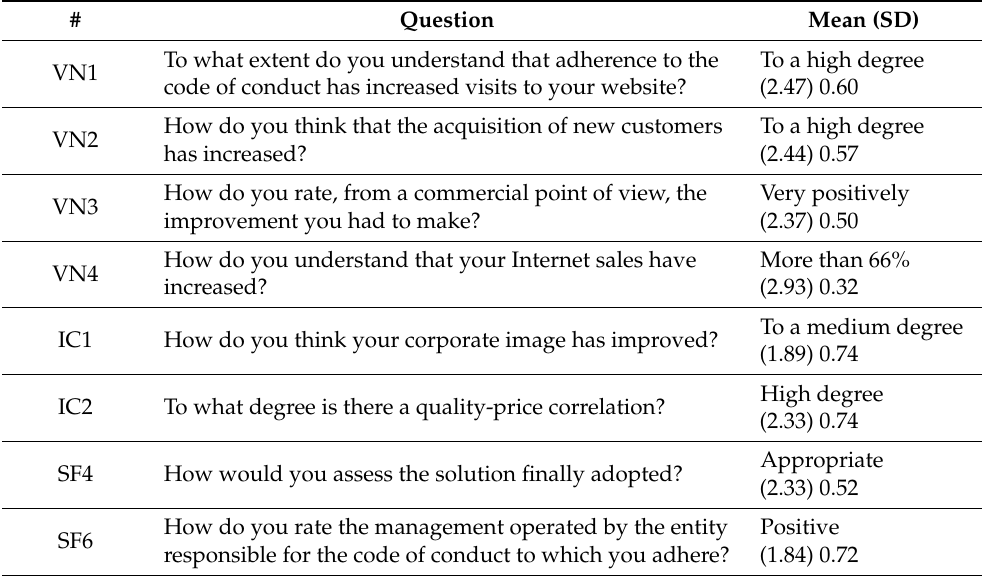
Table 6. Responses (ordinal qualitative